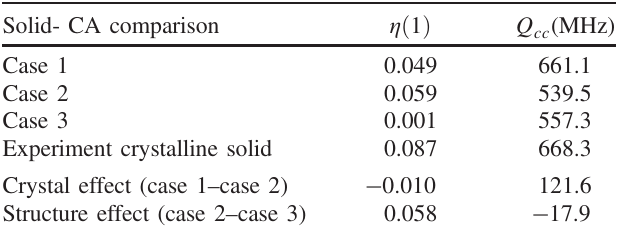
TABLE I. Comparison of QC results at the PBE_SO-ZOR- A_TZ2P level with experimental ones for Q cc and η for triphenylbismuth in different surroundings.